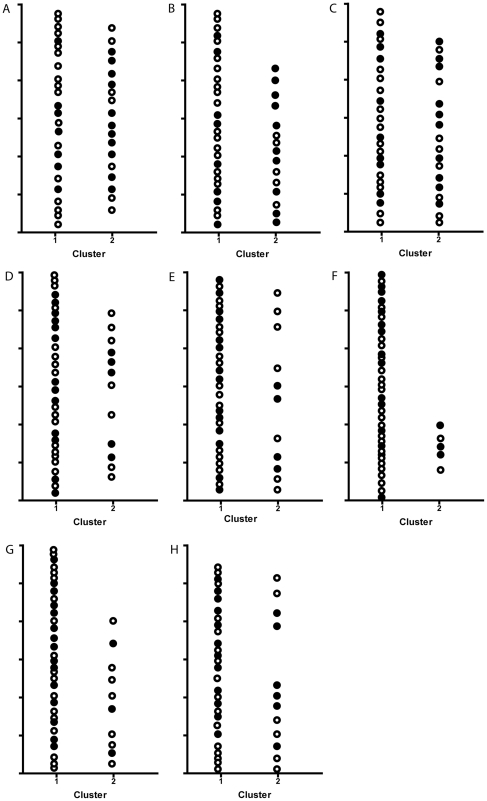
Cluster analysis for the reported transcript sets.K-means cluster analysis based upon the transcript sets reported by (A) Lequerré (20 genes) (B) Stuhlmuller (11 genes) (C) Stuhlmuller (82 genes) (D) Lequerré (8 genes) (E) Sekiguchi (18 genes) (F) Julia (8 genes) (G) Stuhlmuller (3 genes) and (H) Tanino (8 genes). The previously published transcript sets were linked to the expression values of 42 RA patients treated with anti-TNF in our study. The two clusters were identified as the non-responder (1) and responder (2) clusters. Profiles are ranked according the results obtained after clustering, in which profile A showed the best results. • = responder; ○ = non-responder.